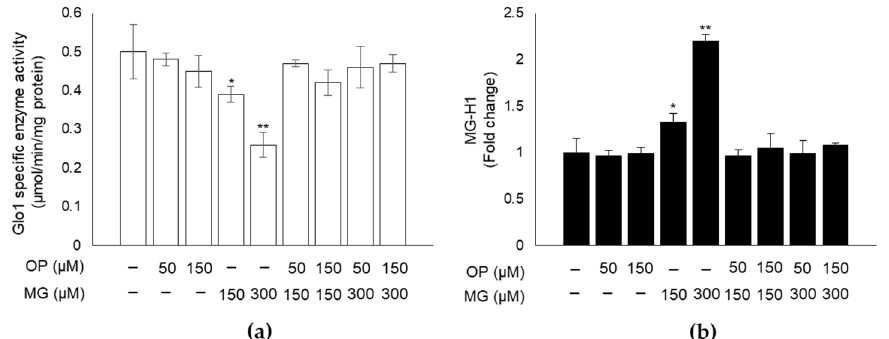
Figure 3. OP prevents MG-dependent dicarbonyl stress in DPSCs. ( a ) OP pretreatment for 24 h was able to significantly revert Glo1 specific activity inhibition and ( b ) MG-H1 intracellular content to the level of control. Histograms indicate the means ± SD of three different cultures, each of which was tested in triplicate. * p < 0.05, ** p < 0.01, significantly different from control untreated cells.